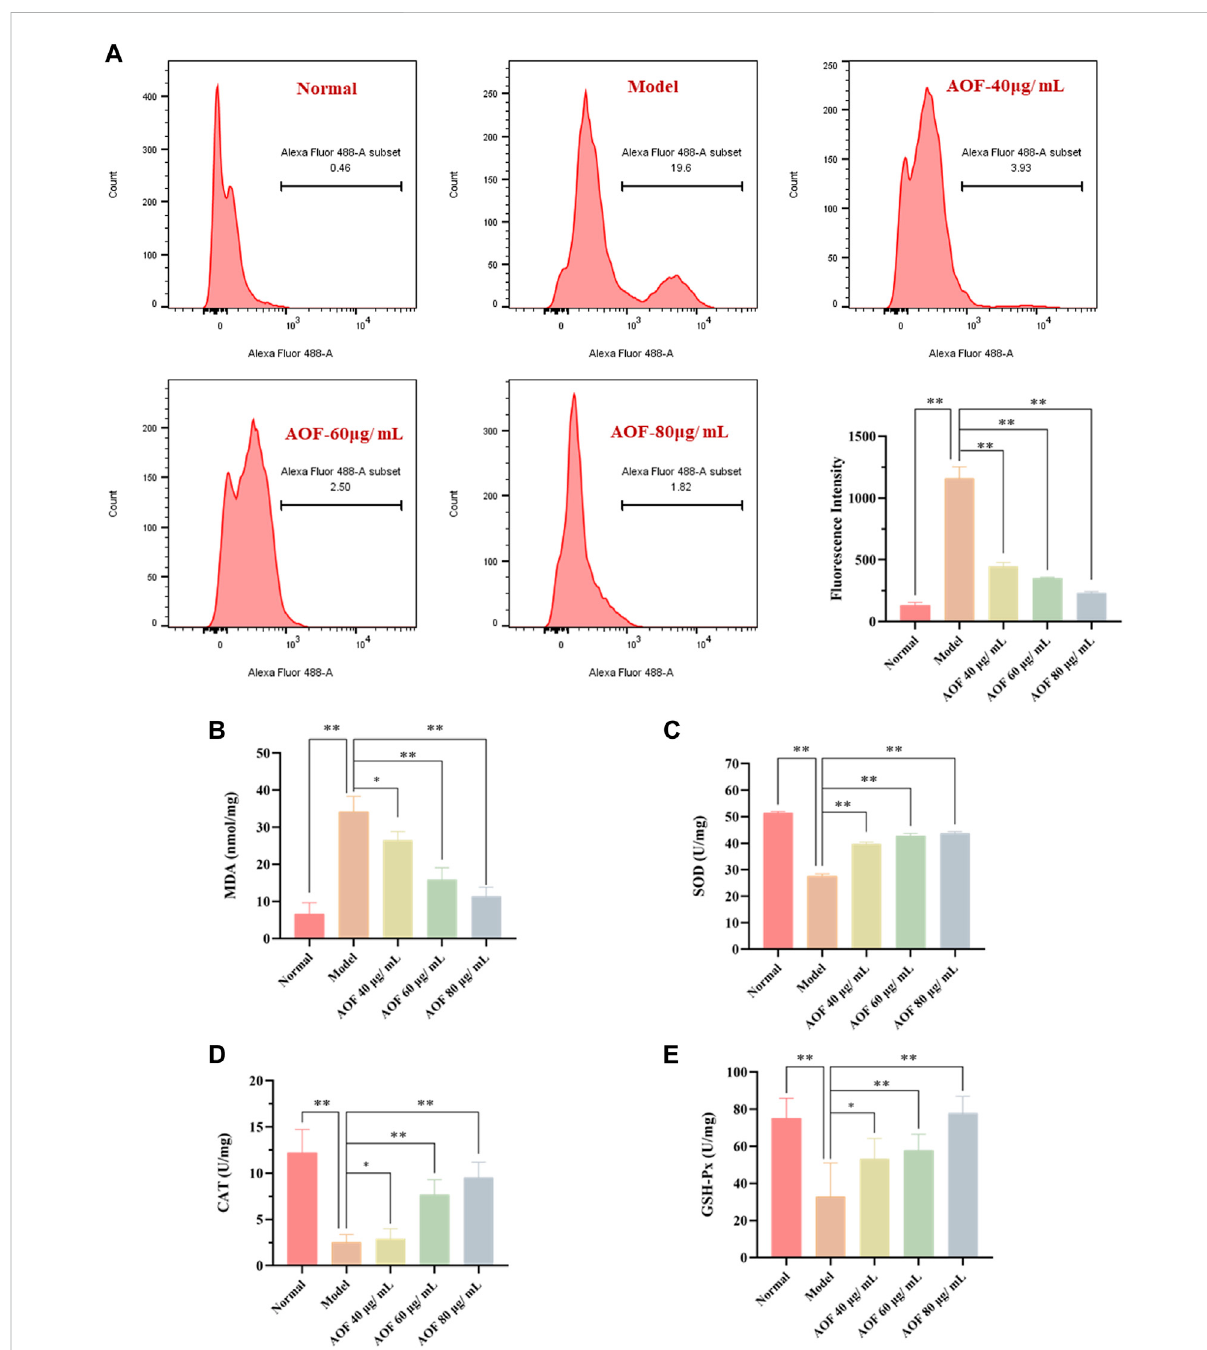
FIGURE 10 Effects of AOF on ROS levels (A) and antioxidant enzyme activities (B – E) in H 2 O 2 -stimulated PC12 cells (A) The intracellular ROS levels were measured using a DCFH-DA assay kit and fl ow cytometry (B – E) The levels of MDA and activities of SOD, CAT and GSH-Px were determined by commercial assay kits. The values were represented as the mean ± SD ( n = 3). * p < 0.05, ** p < 0.01 vs the model